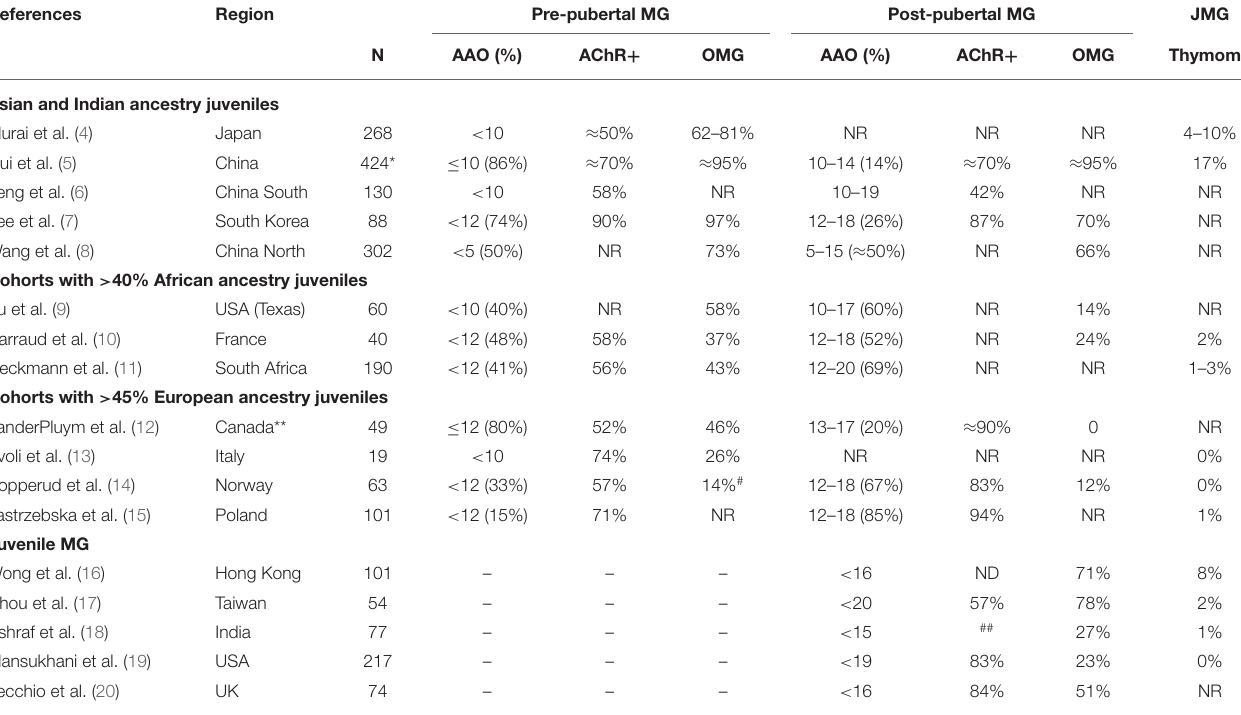
TABLE 1 | Characteristics of juvenile myasthenia gravis (MG) and subgroups (pre-pubertal vs. post-pubertal) by race and/or geographical